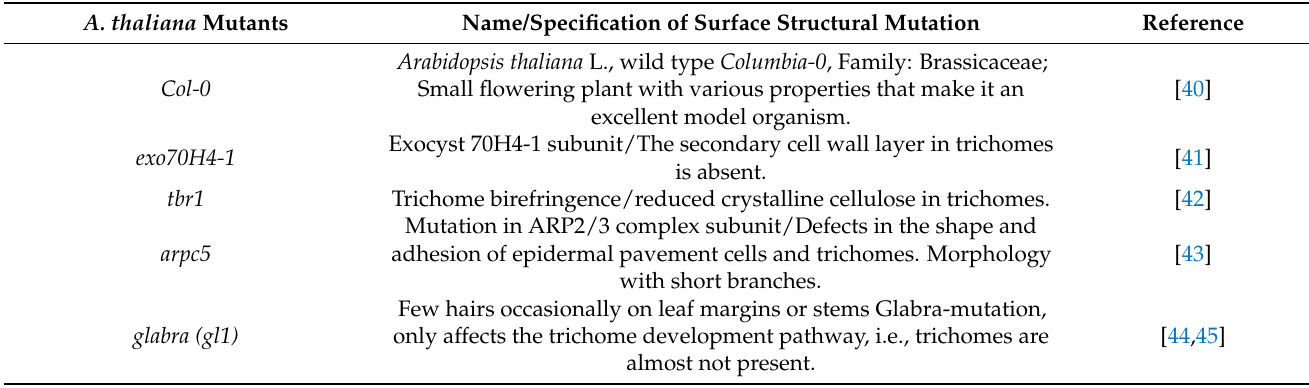
Table 1. Leaf epidermal structural traits of studied plants: wild type Columbia-0 and four A. thaliana structural mutants, with descriptions of surface structural mutation from a referenced